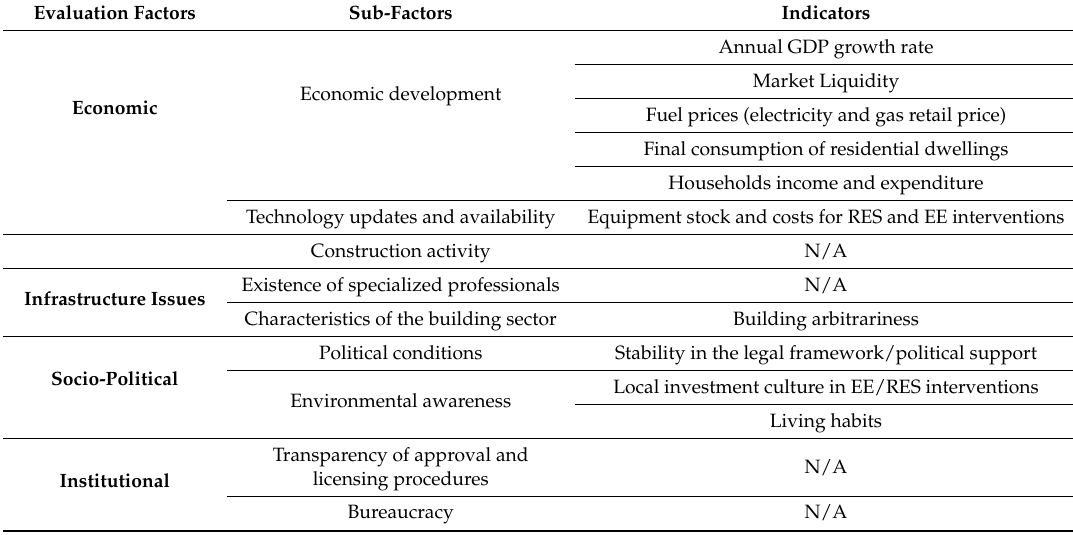
Table 2. Summary of influential contextual factors, their sub-factors and related indicators as identified throughout the stakeholder consultation process (partly adapted by